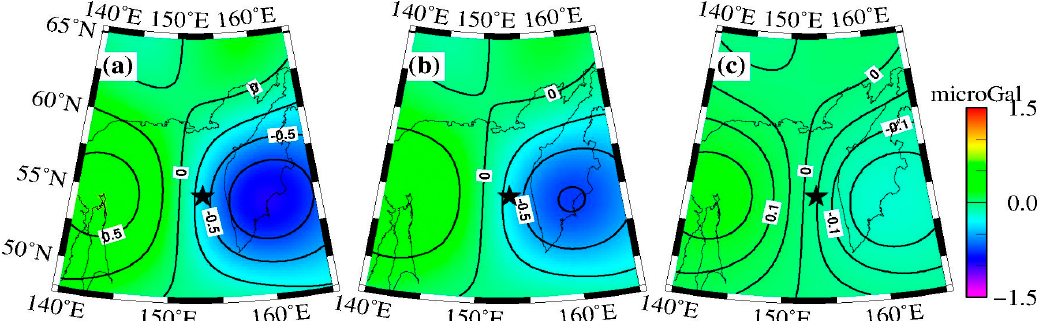
Figure 8. The coseismic gravity changes calculated by the elastic dislocation [24]. ( a ) Total changes; ( b ) Gravity changes caused by vertical deformation; ( c ) Gravity changes caused by density changes. The same P4M6 decorrelated filter + 350 km Gaussian smoothing was applied to GRACE data processing. The black star represents the location of the epicenter, and the contour interval is 0.25 microgal in (a) and (b), 0.1 microgal in (c).